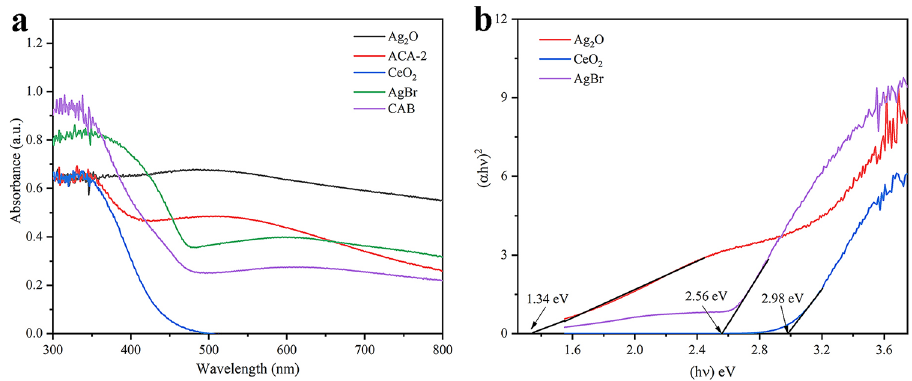
Figure 3. ( a ) UV–Vis DRS of CeO 2 , Ag 2 O, AgBr, AOC and ACA-2; ( b ) bandgap diagram of Ag 2 O, CeO 2 and